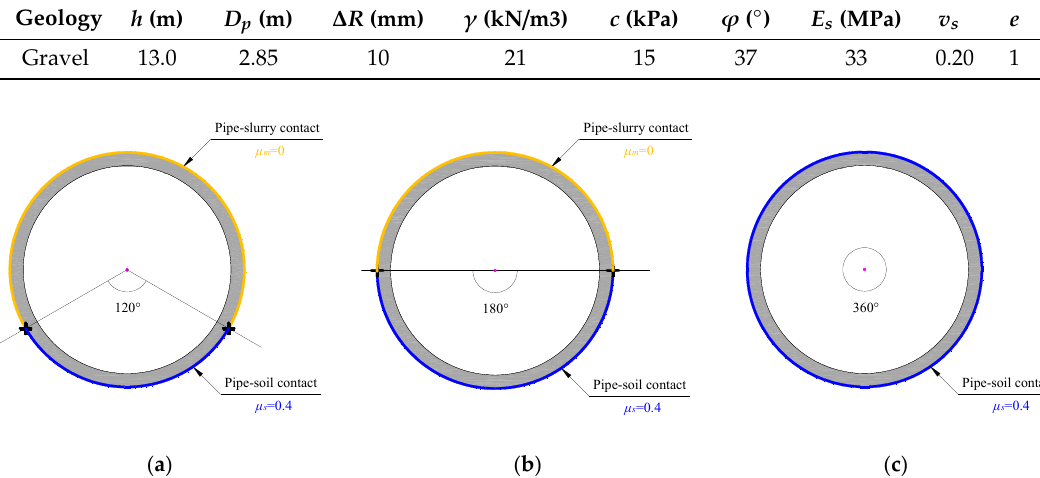
Table 7. The details of the slurry pipe jacking in Taichung Science Park.